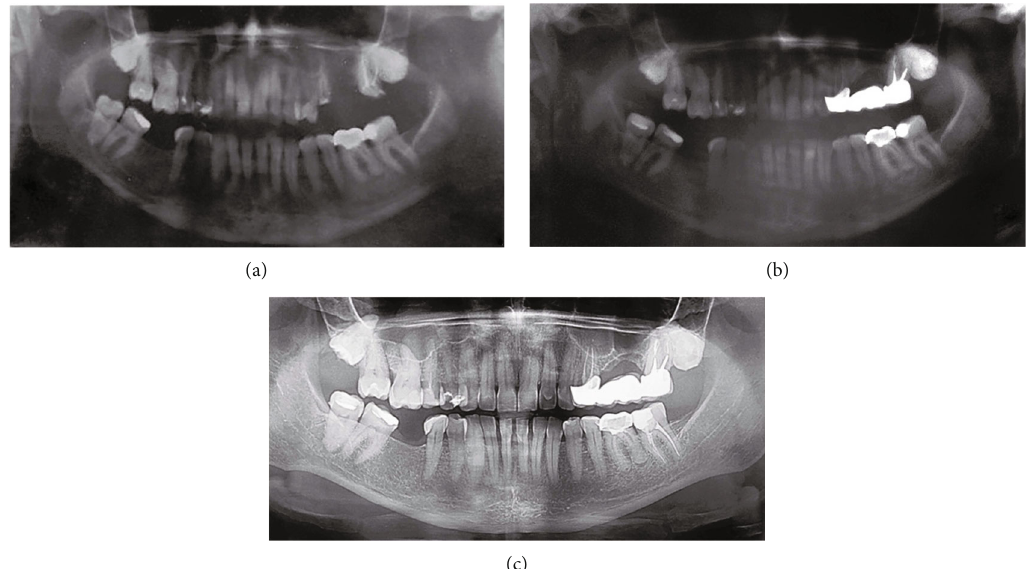
Figure 2: Panoramic radiograph: (a) preoperative radiograph showing bony defect at the postextraction site of tooth 2.6 and failing tooth 2.5; (b) radiograph taken 3 months after surgery showing bone repair; (c) radiograph taken at 8-year follow-up showing the stability of bone volume and absence of any pathological